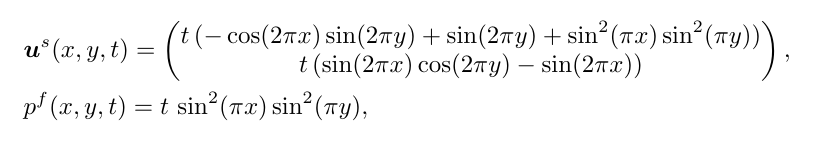
Figure 2. Distorted triangular mesh H h .